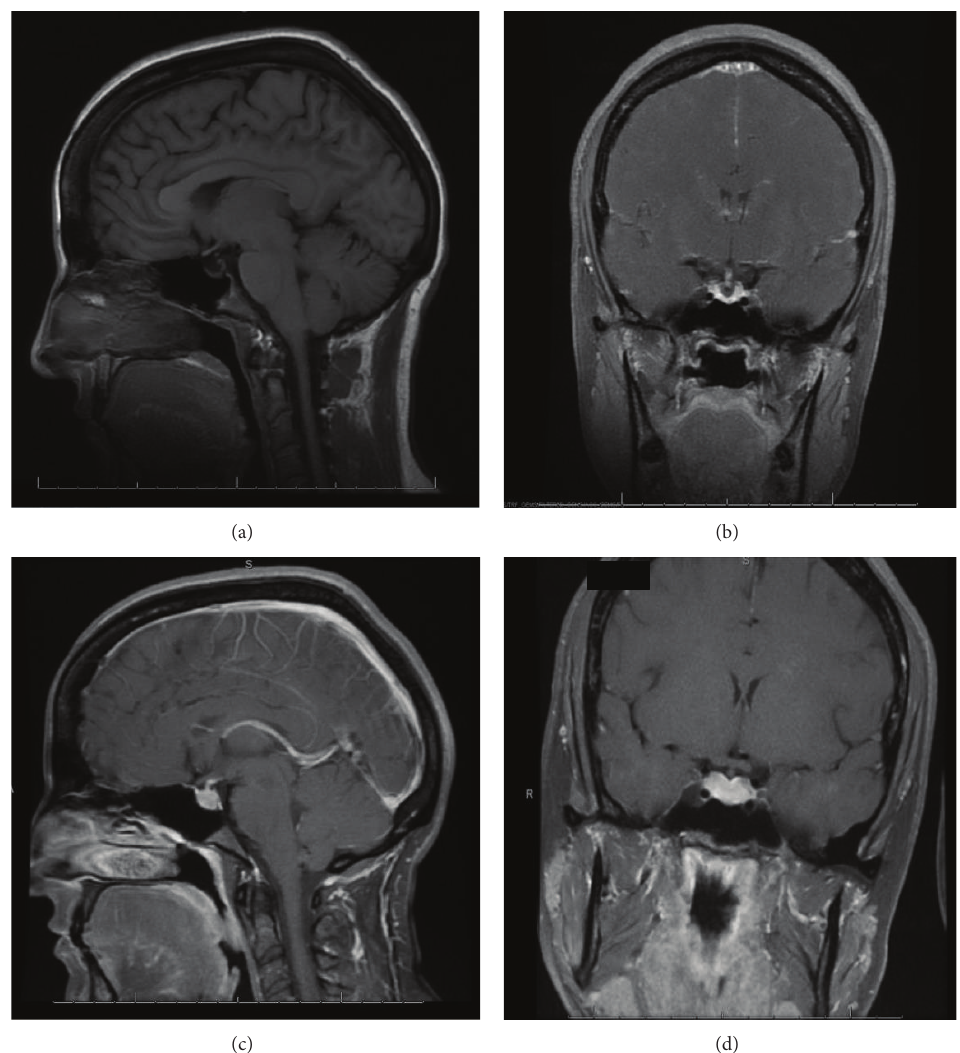
Figure 1: Case MR images. Sagittal (a) and coronal (b) unenhanced images of the pituitary, revealing a slightly atrophic pituitary gland. Two months later, at presentation, sagittal (c) and coronal (d) postcontrast images reveal an enlarged pituitary size with diffuse enhancement of the pituitary and infundibulum without focal